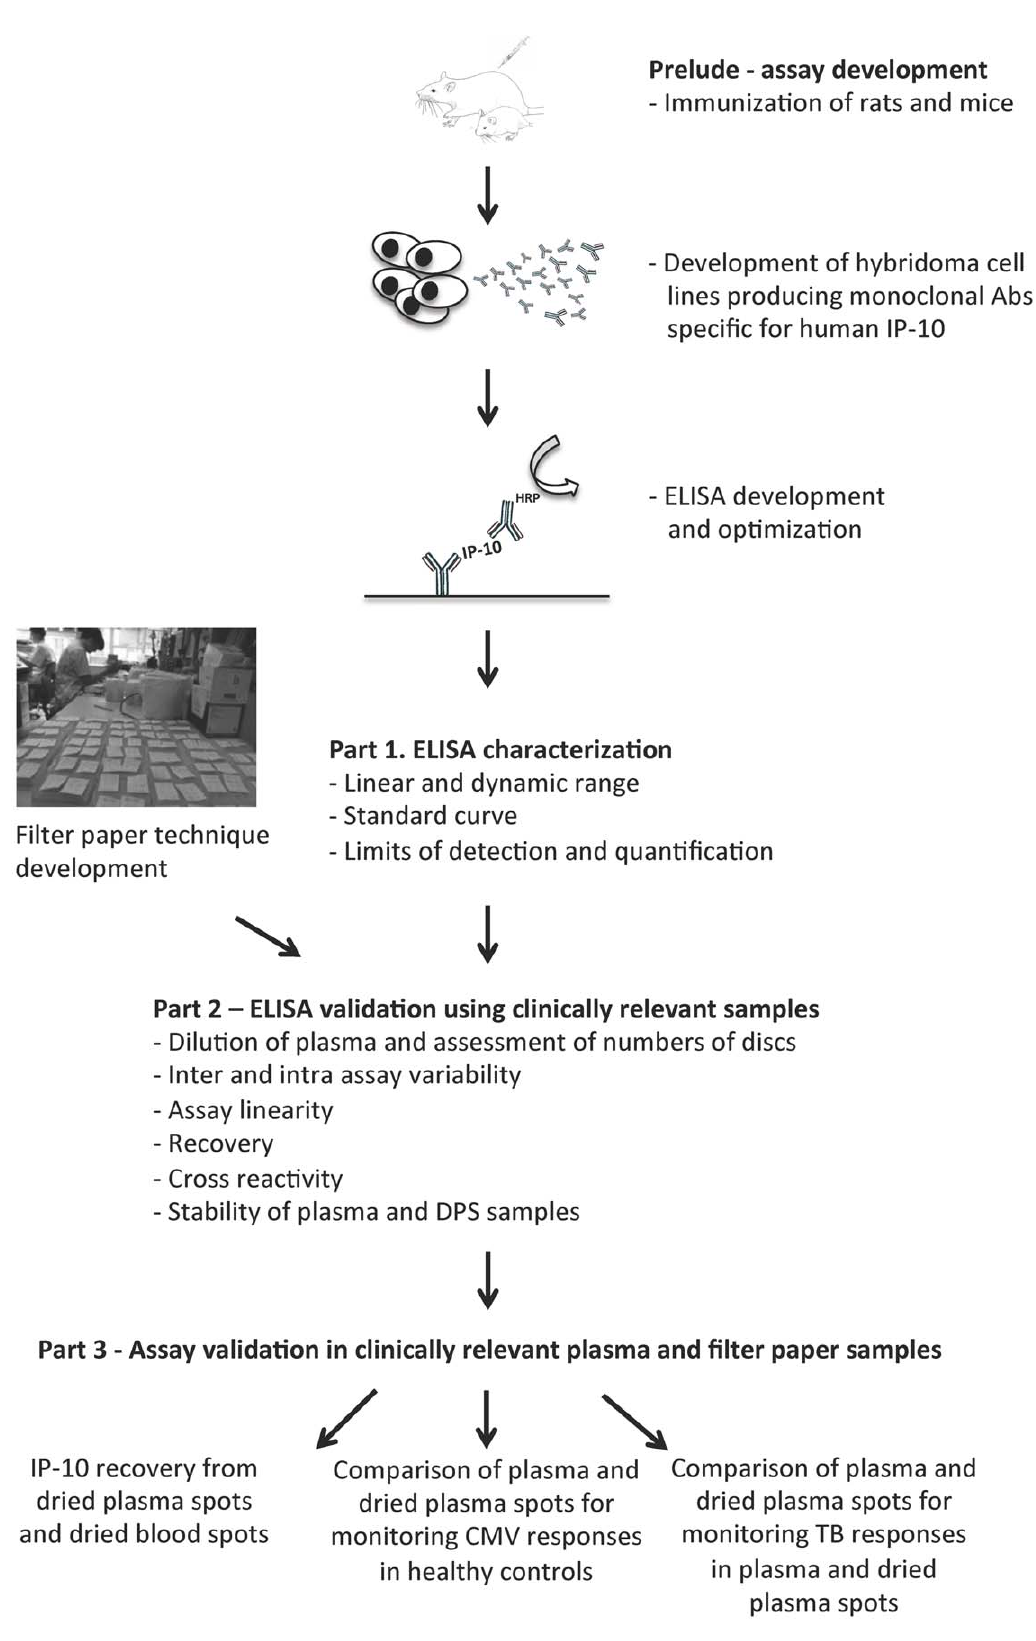
Figure 1. Overview of the development and validation process.